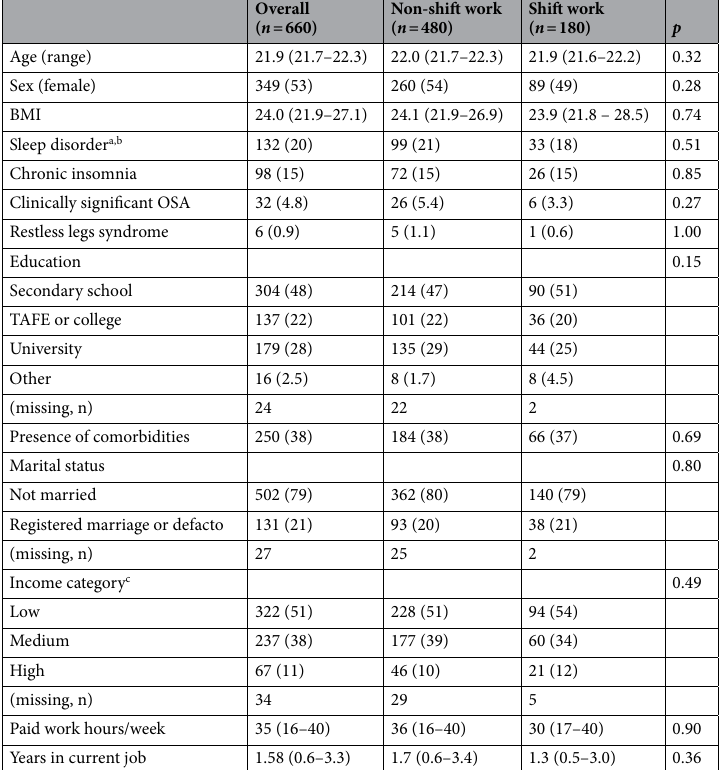
who identified as shift workers were included in the primary analysis.